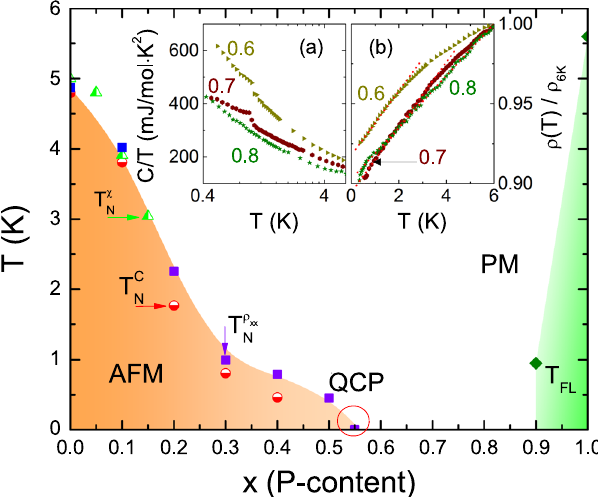
Figure 6. Phase diagram of CeNi 2 − δ (As 1 − x P x ) 2 as a function of P concentration x . Solid squares, half-filled triangles, and half-filled circles correspond to the AFM transition temperatures from different property measurements: electrical resistivity, magnetic susceptibility and specific heat. Fermi liquid state is recovered below T FL which is shown as filled diamonds. Around x c = 0.55, QCP is marked by a circle. Inset ( a and b ) respectively show the specific heat divided by temperature, C / T versus log( T ), and the normalized electrical ρ , below 6 K for x = 0.6, 0.7 and 0.8. The dashed lines are linear fits to ρ T ( ) resistivity, ρ T ( ) / xx K 6